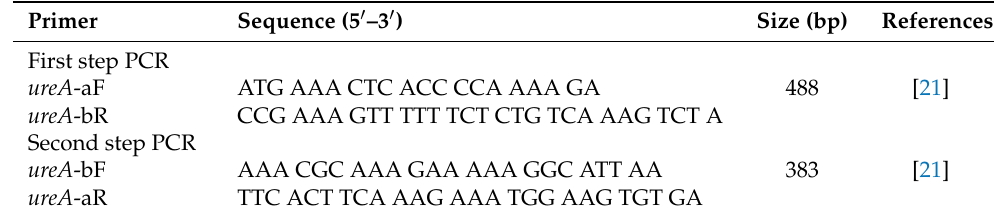
Table 1. H. pylori detection primers.